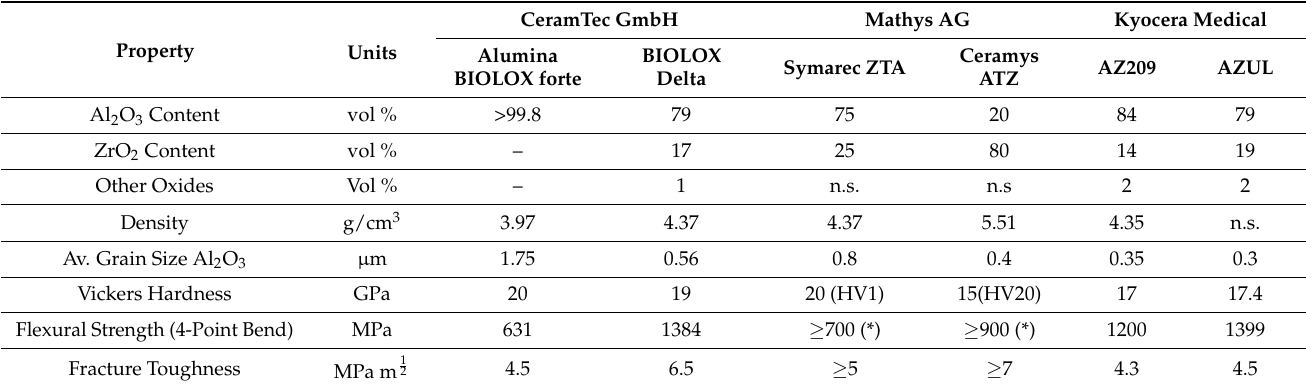
Table 3. Selected properties of alumina–zirconia composites for orthopedic applications. Adapted from [31]. (n.s.: not specified; *: measured by ring-on-ring